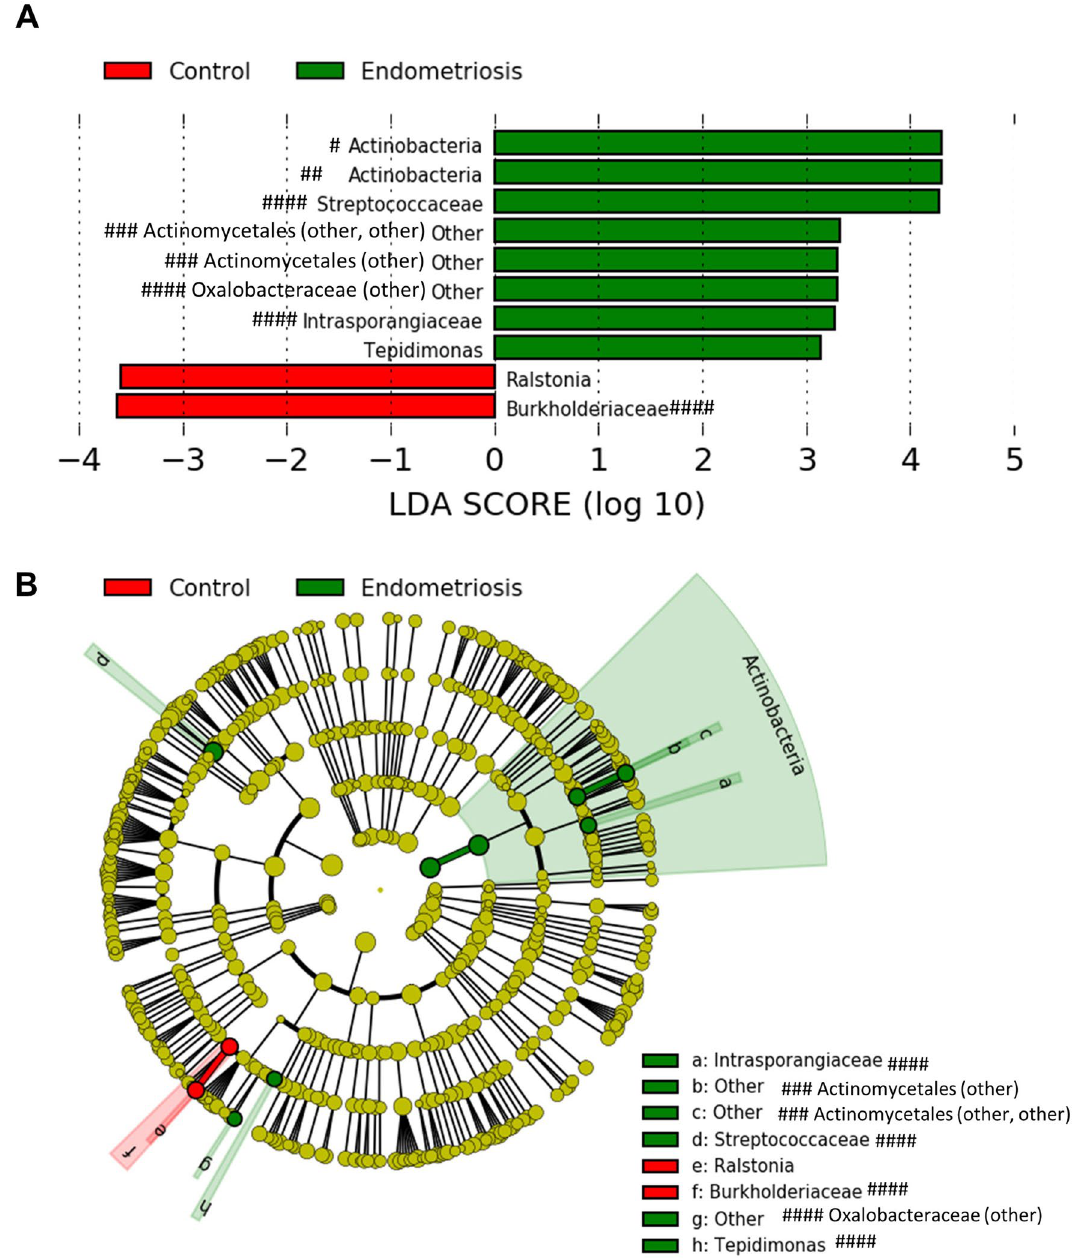
Figure 4. Differential bacterial taxa in the endometrial microbiota of patients with endometriosis versus symptomatic controls. ( A ) Linear Discriminant Analysis effect size (LefSe) analysis separated the endometrial microbiota of patients with endometriosis from control women with pelvic pain based on relative abundance of the bacterial genera listed, using 2.0 as a threshold for discriminative features, and p ≤ 0.05 for statistical tests. LEfSe analysis revealed enrichment of taxa including bacteria in the Actinobacteria phylum, Oxalobacteraceae and Streptococcaceae families, and Tepidimonas genus in patients with endometriosis, while symptomatic controls were found to have enrichment of the Burkholderiaceae family, and Ralstonia genus. ( B ) Cladogram of differential taxa in the endometrial microbiota of patients with endometriosis (in terms of relative abundance— enriched taxa in green) and controls with pelvic pain, but without endometriosis (enriched taxa in red). #: Resolved to bacterial phylum. ##: Resolved to bacterial class. ###: Resolved to bacterial order. ####: Resolved to bacterial